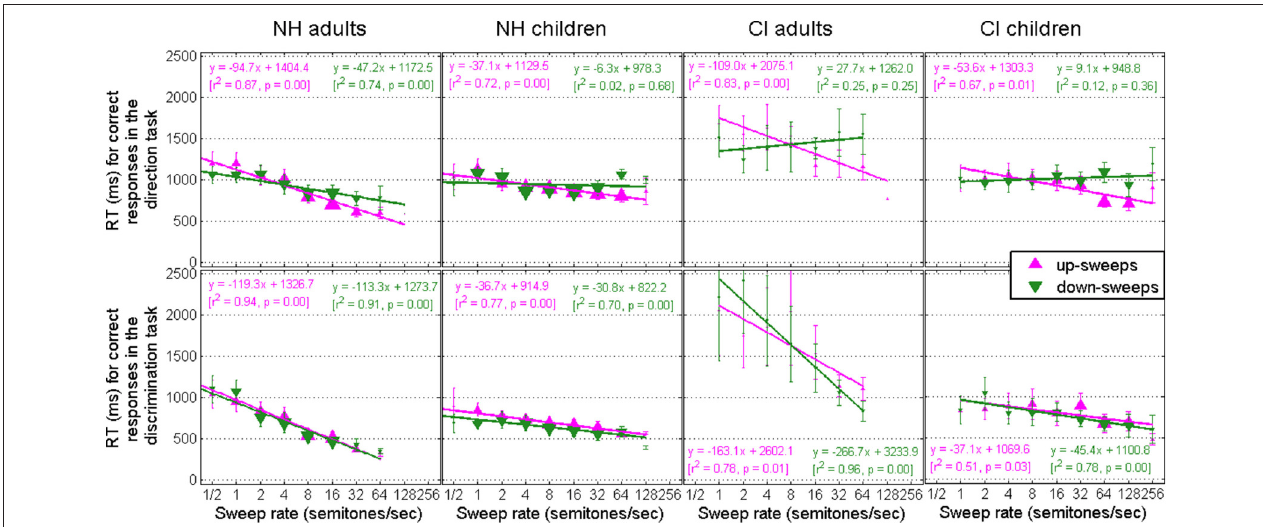
FIGURE 5 | Response Time data in the direction (top) and discrimination (bottom) tasks for trials that provided correct responses. The consistent decrease in RT with rate is evidence of good behavior.